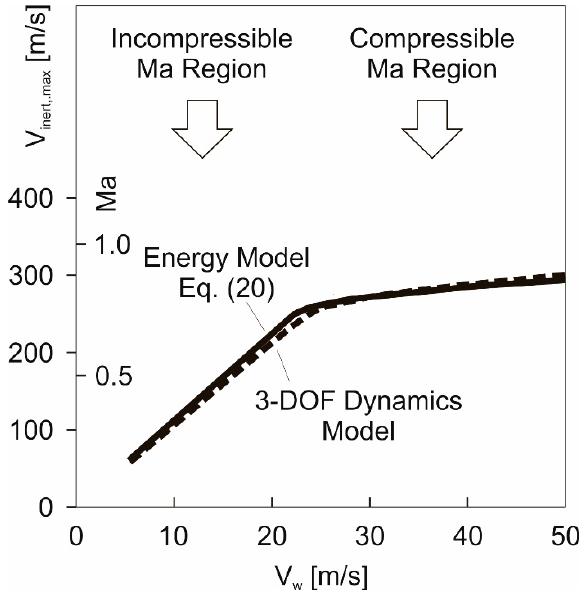
Figure 9. Maximum speed, V inert , max , dependent on wind speed, V w